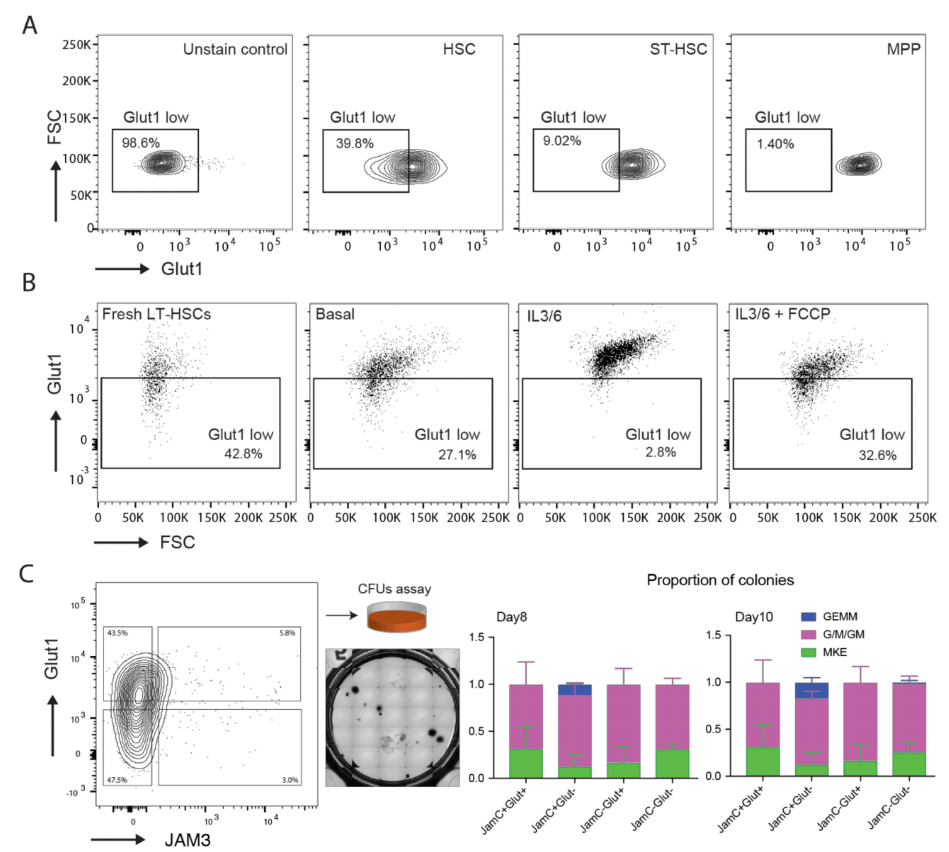
Figure 3. Characterization of Glut1 and JAM3 as markers for asymmetric division in HSCs. ( A ) Expression of Glut1 was tested in di ff erent populations of the hematopoietic hierarchy using flow cytometry. HSCs (HSCs, LKS CD150 + CD48-CD34-), short term HSCs (ST-HSCs, LKS CD150 + CD48-CD34 + ), and multipotent progenitors (MPPs, LKS CD150-) were identified using a combination of cell surface markers and stained with Glut1 to be analyzed by flow cytometry. Glut1 levels changed dramatically from HSCs (Glut1 low ~40%) to ST-HSCs (Glut1 low ~9%) to MPPs (Glut1 low ~1.5%), with concomitant increase as we move down in the hematopoietic hierarchy; ( B ) Glut1 expression in HSCs after 3 days of in vitro culture was assessed using flow cytometry. HSCs cultured in basal media show a small loss of Glut1 low fraction as compared with fresh uncultured HSCs. Di ff erentiation inducing (IL3 / 6) condition shows a striking loss of Glut1 low fraction, with overall Glut1 levels going up. The addition of FCCP (mitochondrial uncoupler) to the IL3 / 6 condition reverts this loss of Glut1 low fraction and brings down the level of Glut1 expression; ( C ) HSCs were cultured for three days in basal media and were sorted for Glut1 and JAM3 post culture. The stem cell potential of these sorted cells was determined by their colony-forming unit (CFU assay) ability. Glut1 low JAM3 high cells show a significant increase in the proportion of more primitive (GEMM) colonies and concomitant decrease in the less primitive (Mk / E) colonies, suggesting Glut1 low JAM3 high cells are more primitive than other populations (i.e., Glut1 high JAM3 low, Glut1 high JAM3 high, Glut1 low JAM3 high). (CFU-)G, colony-forming unit-granulocyte; (CFU-)M, colony-forming unit-macrophage; (CFU-)GM, colony-forming unit-granulocyte, macrophage; (CFU-)GEMM, colony forming unit-granulocyte, erythrocyte, macrophage, megakaryocyte); Mk / BFU-E, megakaryocyte / burst-forming